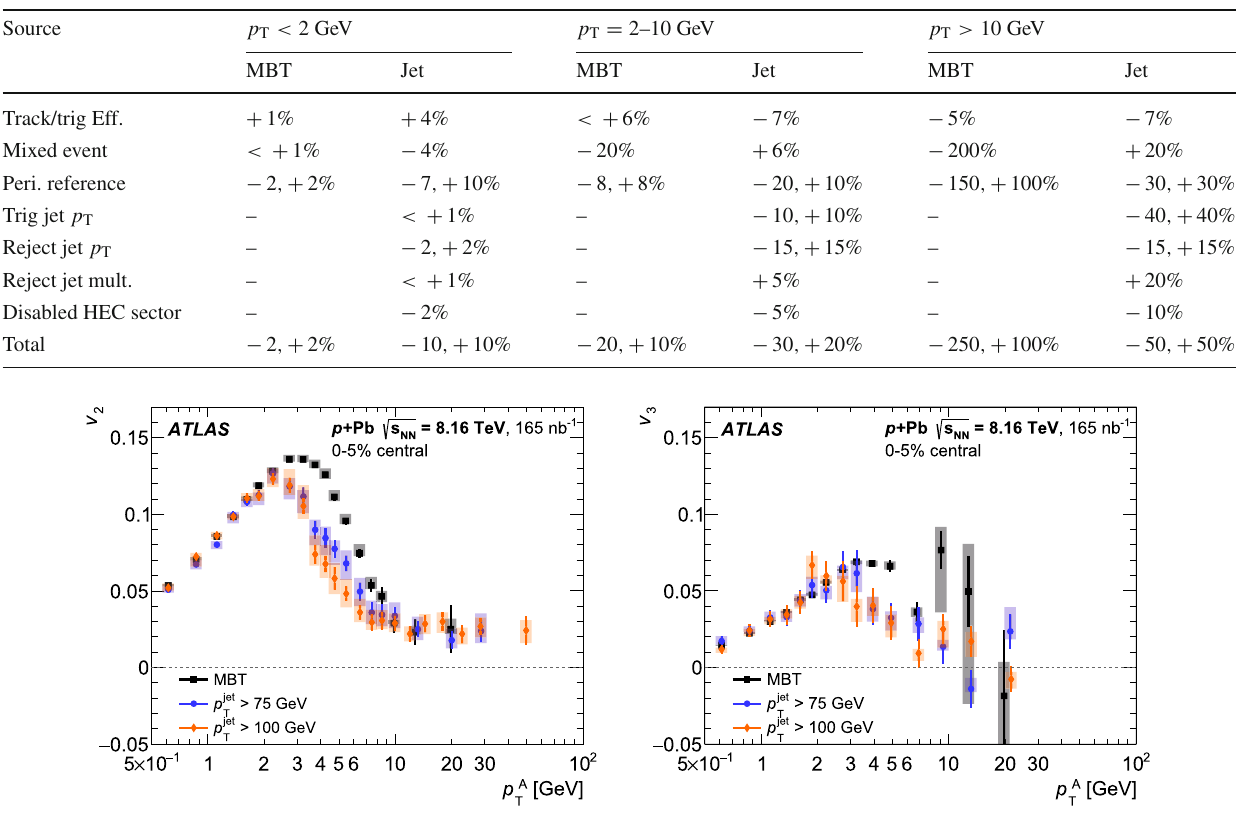
Fig. 3 Distribution of v 2 (left) and v 3 (right) plotted as a function of the A-particle p T . Values from MBT events are plotted as black squares, and those from events with jet p T > 75 GeV and events with jet p T > 100 GeV are plotted as blue circles and orange diamonds